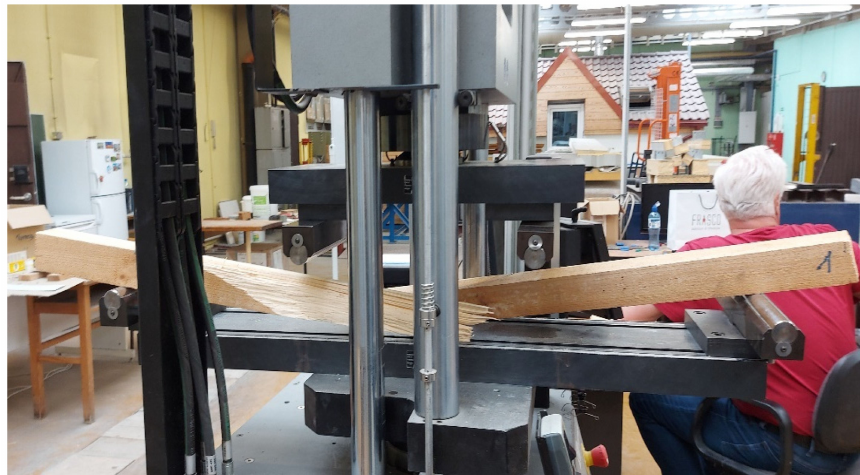
Figure 5. Scheme of the bending strength test according to [39].